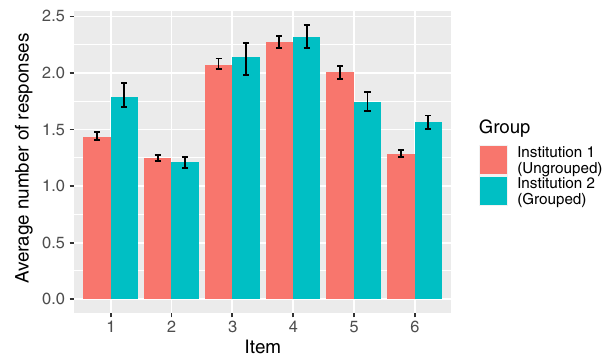
FIG. 5. Average number of answer choices selected on paper by Institutions 1 and 2 students for the six MCMR PIQL items with items grouped or